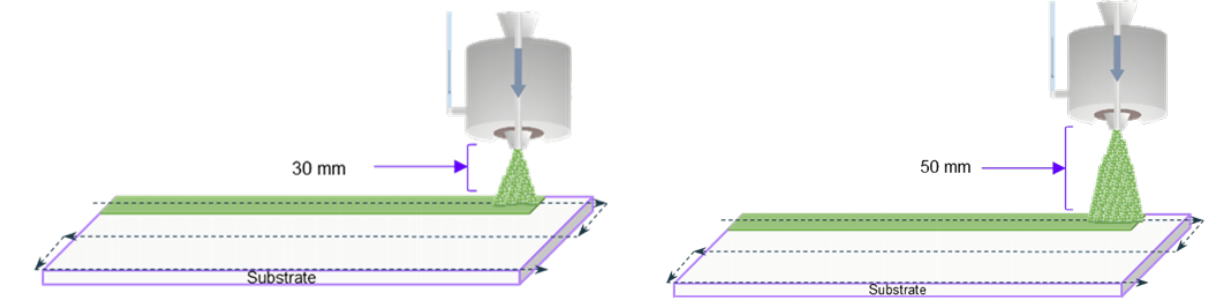
Figure 7. Schematic illustration of the substrate – nozzle distance.